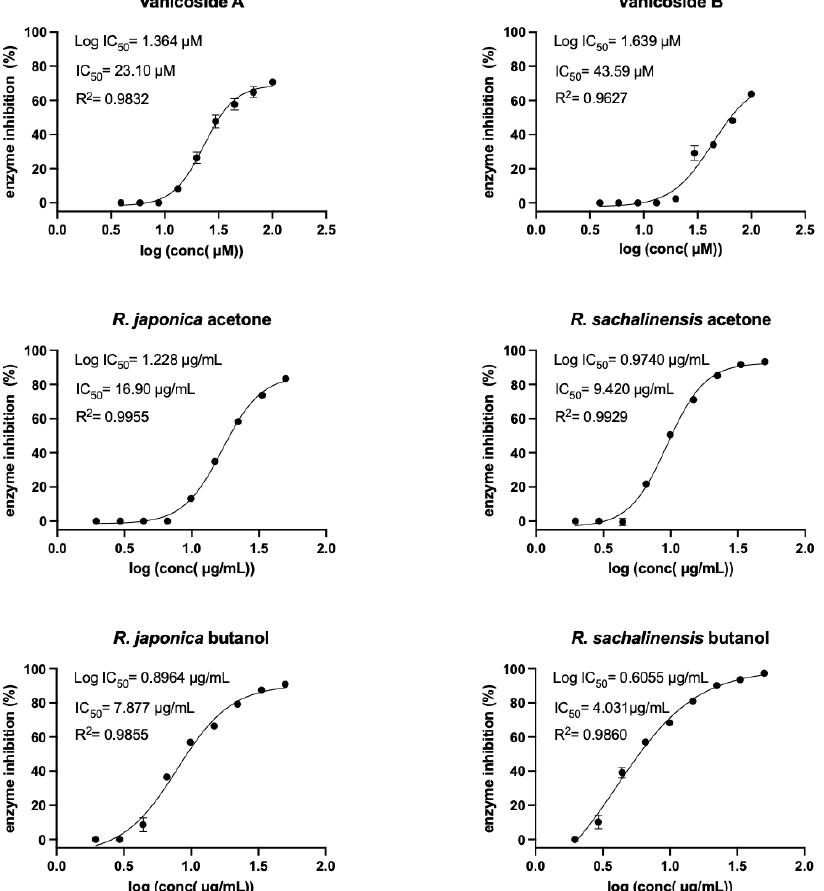
Figure 8. SARS-CoV-2 Mpro activity in serial dilution of the most potent inhibitors. Log IC 50 , IC 50 and R 2 were calculated for each sample.